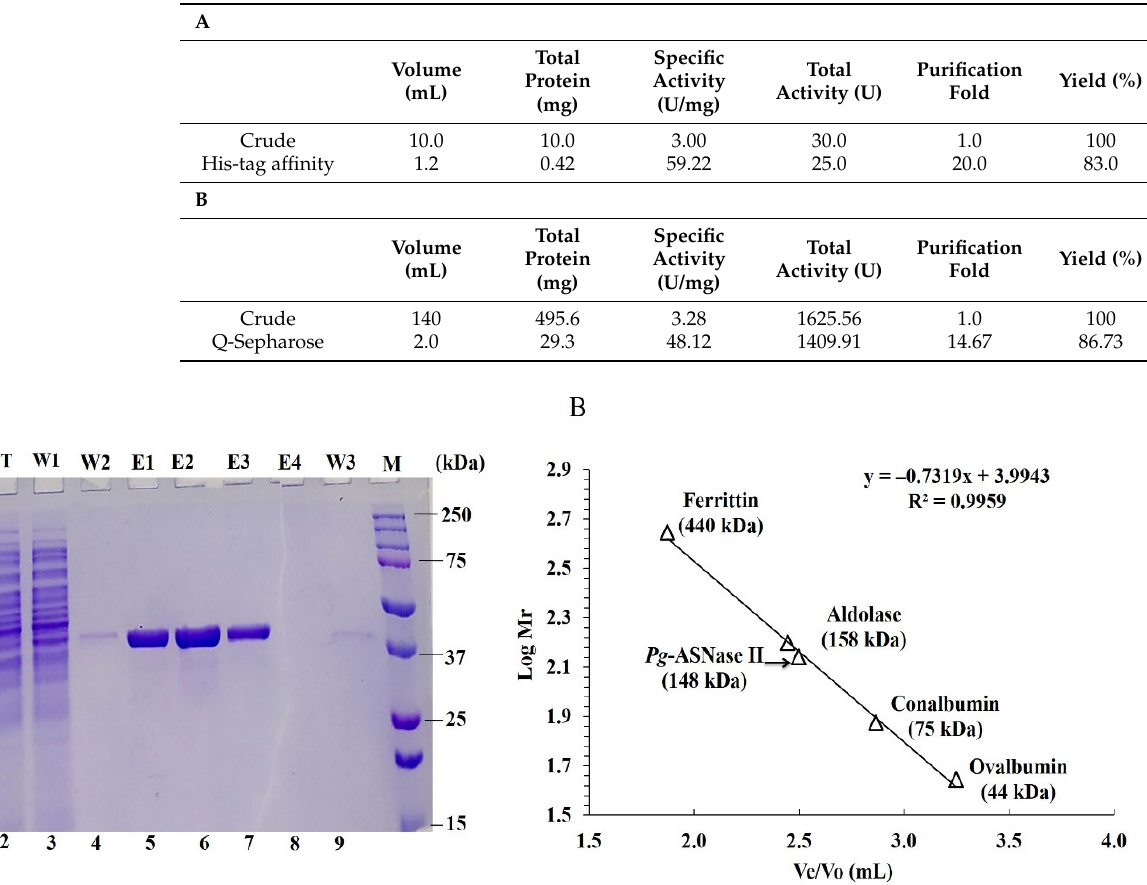
Figure 2. Polyacrylamide gel electrophoresis and molecular weight estimation of His-tagged Pg -ASNase II. ( A ) SDS‒PAGE (12%) analysis of recombinant Pg -ASNase II. Lane 1 is total cell lysate; lane 2 is flow-through; lane 3 is a wash (W1) with 5.0 mM imidazole; lane 4 is a wash (W2) with 20.0 mM imidazole; lane 5–8 is eluted protein (E1–E4); lane 9 is a final wash (W3) with 250.0 mM imidazole, and M is protein molecular weight marker. ( B ) Determination of the molecular mass of the native Pg -ASNase II. Gel filtration chromatography was performed using Superdex 200 (10/300 GL) column. Arrow indicates the log MW of the Pg -ASNase II. Ferritin, aldolase, conalbumin, and ovalbumin were used as protein molecular weight standards for standard curves. V e and V o indicate for elution volume of each protein and void volume, respectively.